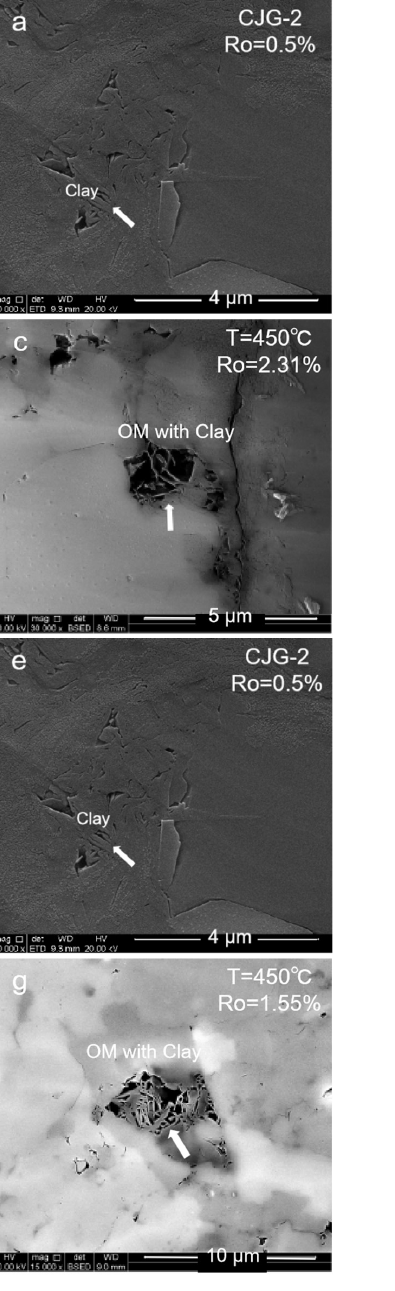
Figure 5. Evolution of the clay mineral pores in the two groups under different temperatures. ( a ) Original sample, little clay mineral pores were developed. ( b ) Group 1, semiclosed system, T = 350 °C, the clay mineral pores were enlarged. ( c ) Group 1, semiclosed system, T = 450 °C, no significant change in the clay mineral pores. ( d ) Group 1, semiclosed system, T = 500 °C, the clay mineral pores were squeezed. ( e ) Original sample, little clay mineral pores were developed. ( f ) Group 2, open system, T = 350 °C, the clay mineral pores were enlarged. ( g ) Group 2, open system, T = 450 °C, no significant change in the clay mineral pores. ( h ) Group 2, open system, T = 500 °C, the clay mineral pores were squeezed.